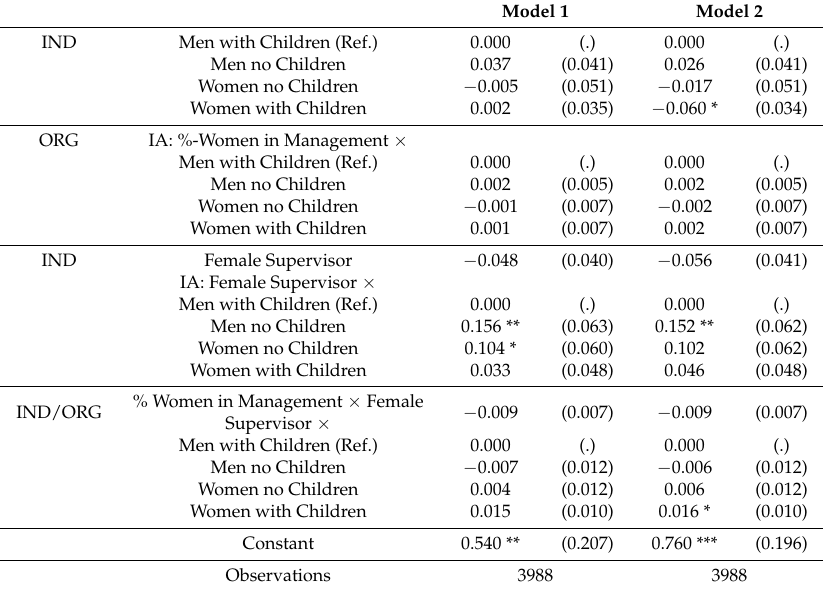
Table 6. Gender Gap in Claims-Making and Gendered Power Structure (results of linear fixed-effects regressions).